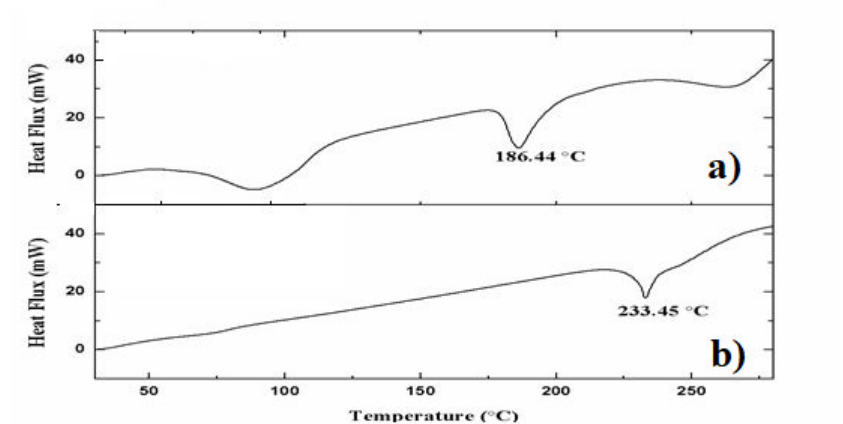
FIGURE 6 - DSC thermogram of a) OND HCl; b)